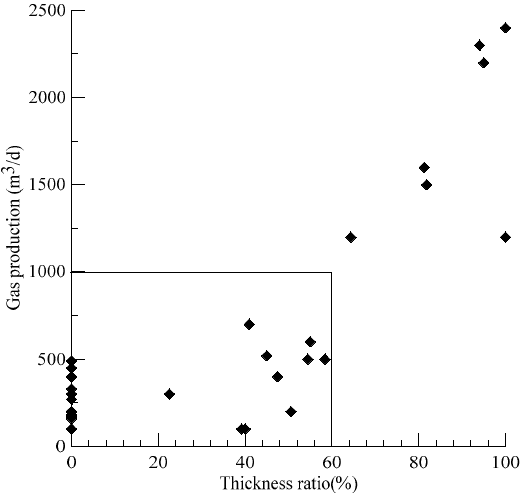
Figure 10. The thickness ratio of well-preserved coal vs. gas production of the No. 11 coal seam in 36 exploitation wells.